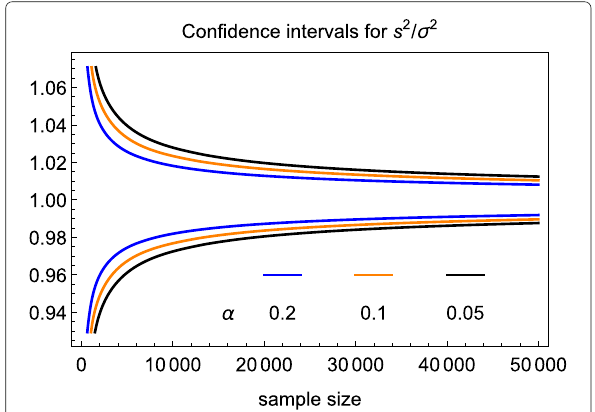
Fig. 3 Confidence intervals for the ratio s 2 /σ 2 derived by using normal approximation for vehicle